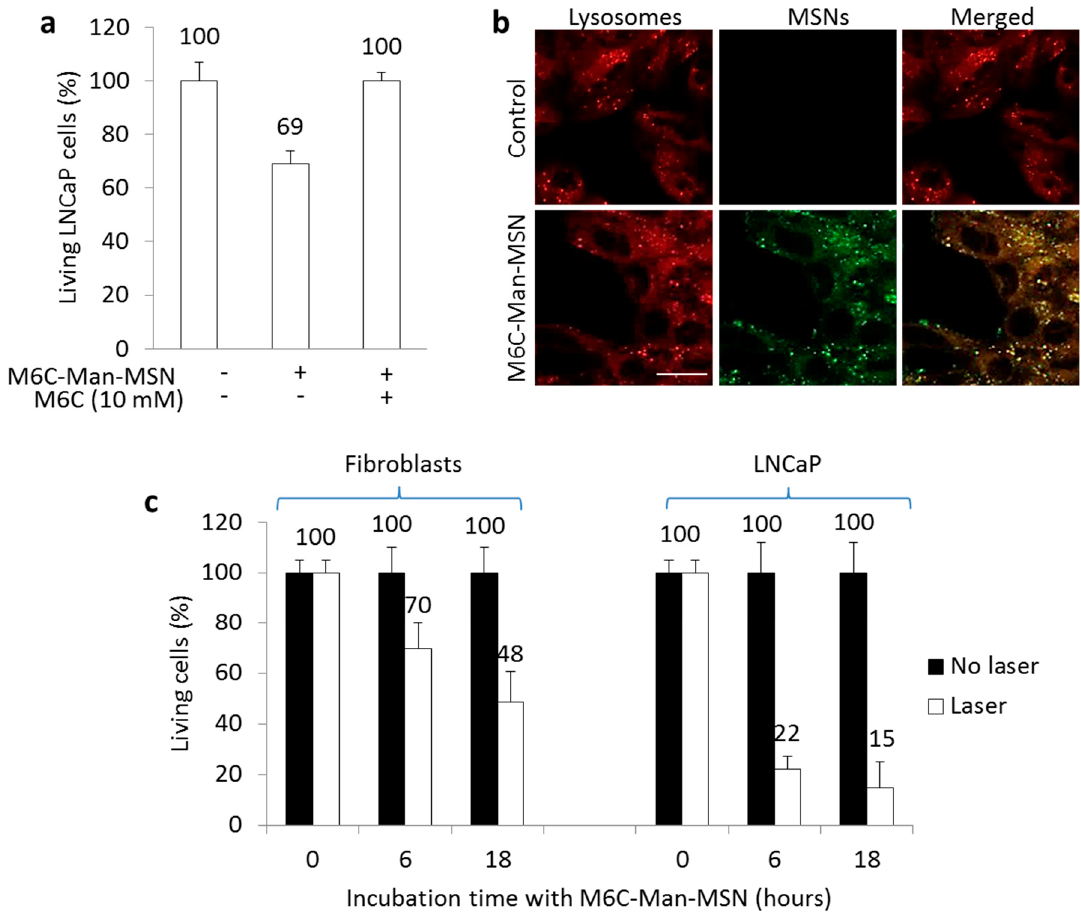
Figure 3. Analysis of M6C-Man-MSN e ffi ciency to target cation-independent mannose 6-phosphate receptor (CI-M6PR) on prostate cancer cells. ( a ) photodynamic therapy e ff ect of M6C-Man-MSN at 80 µ g · mL − 1 incubated for 4 h, in the presence or in the absence of an excess of M6P (10 mM). All conditions were irradiated. ( b ) Fluorescence imaging for colocalization study of M6C-Man-MSN (green) with lysosomes (red); the colocalization of MSN and lysosomes is characterized by the yellow color. Cells were incubated for 24 h with MSN-Man-M6C. Scale bar: 10 µ m. ( c ) Di ff erential study of PDT e ffi ciency between healthy fibroblasts with a normal expression level of CI-M6PR and LNCaP prostate cancer cells expressing an elevated level of CI-M6PR. Values are means ± SD of three experiments.